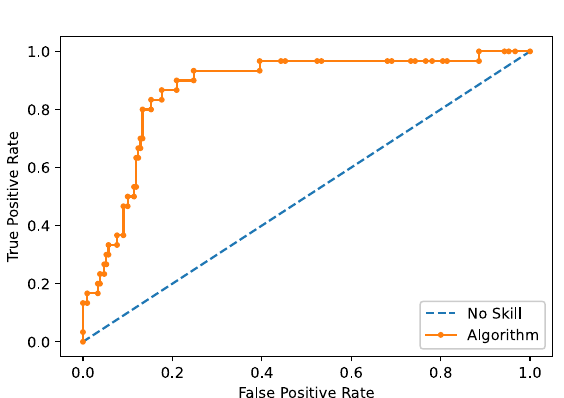
Figure 6. Confusion matrix obtained after optimizing parameters using data not previously seen by the algorithm for the validation of the results. In this case, label 0 means that the patient is alive after infection, whereas 1 means that the patient dies.